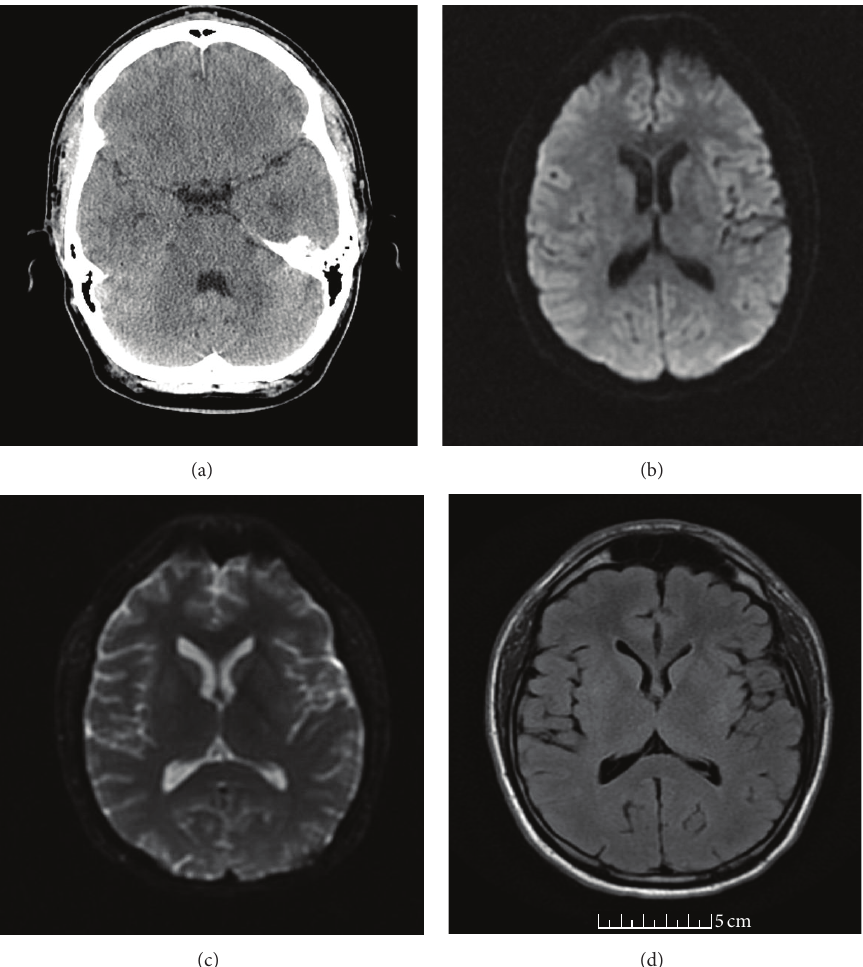
Figure 1: CT scan of brain without contrast was unremarkable (a) and axial MRI of the brain (DWI, ADC map, and FLAIR, resp., (b), (c), and (d)) at the level of basal ganglion was